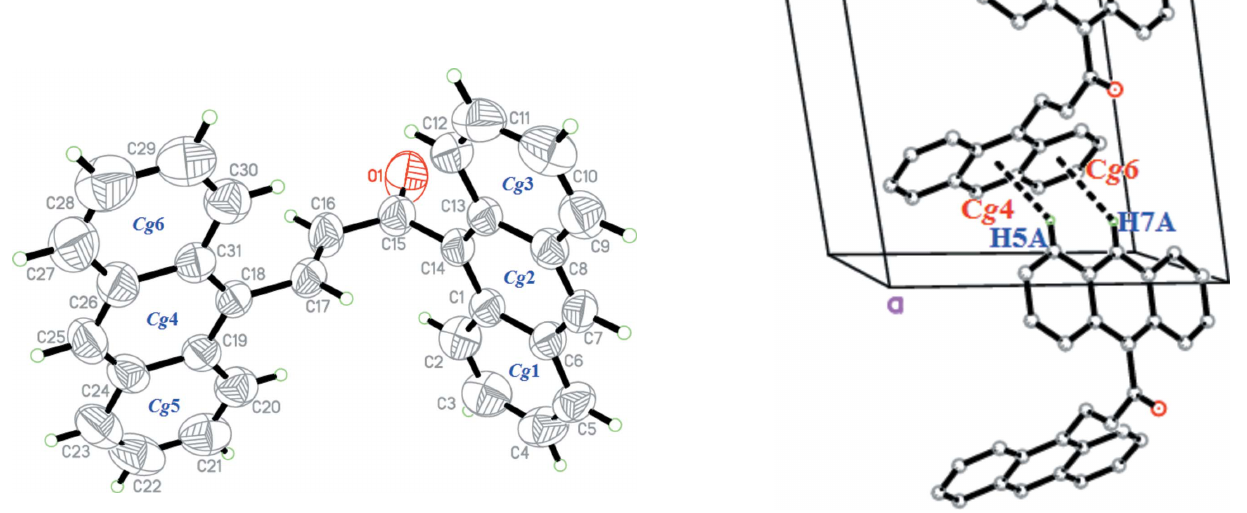
Figure 1 The molecular structure of (I) showing 50% displacement